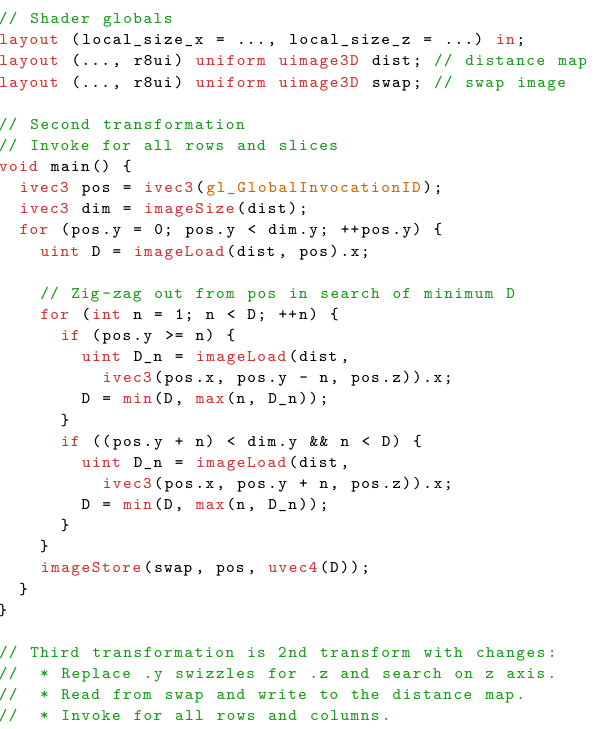
Algorithm 3 The second and third of the occupancy map to Chebyshev distance map transformations